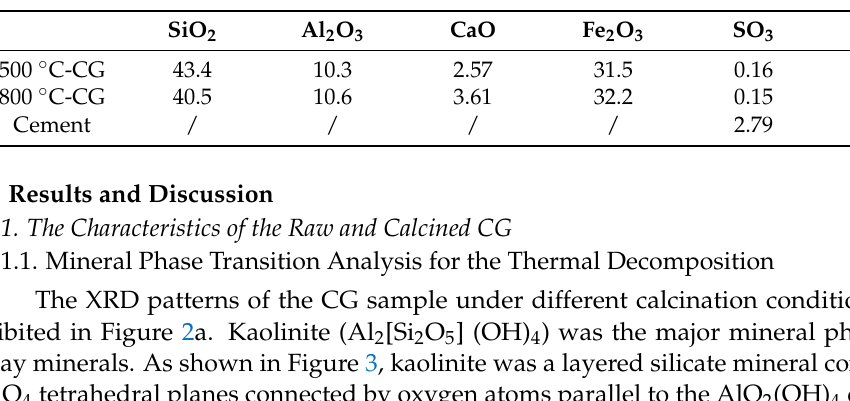
Table 1. The chemical composition of calcined CG and